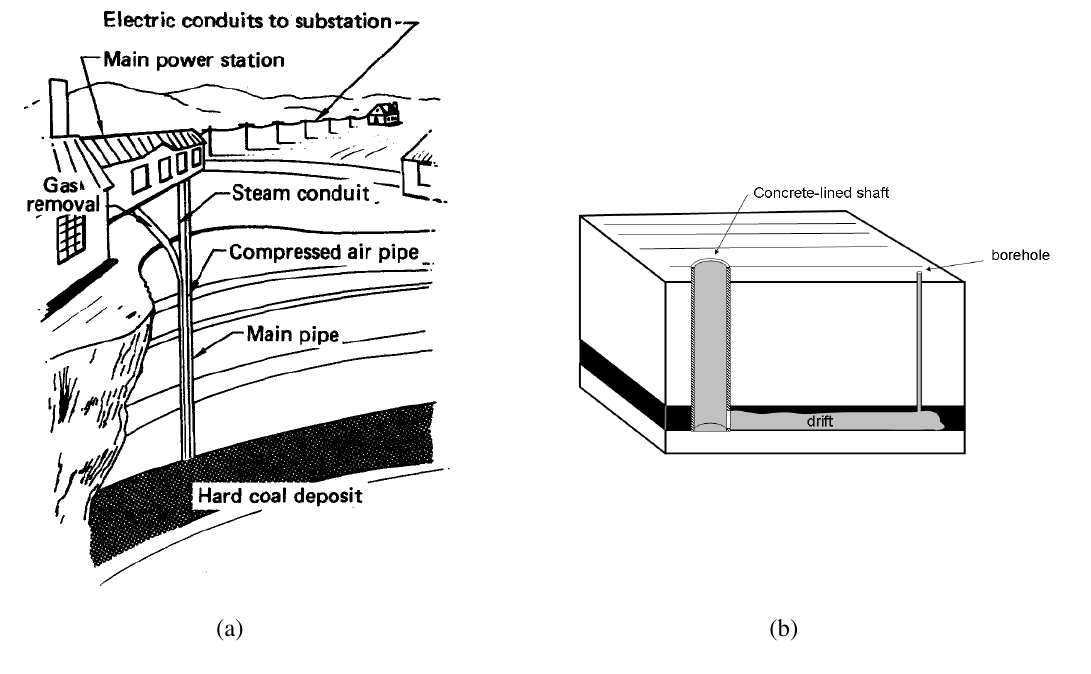
Figure 2. Underground gasification schemes that were (a) mentioned [7, 19] and (b) used by